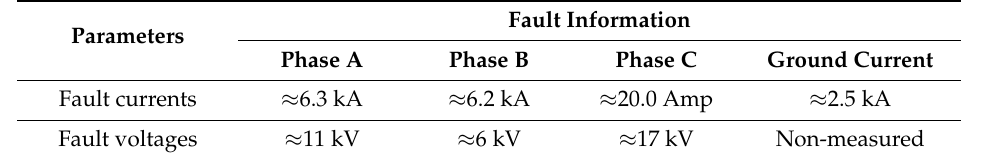
Table 15. Fault information at F2 on the 473 Go-Noi feeder.